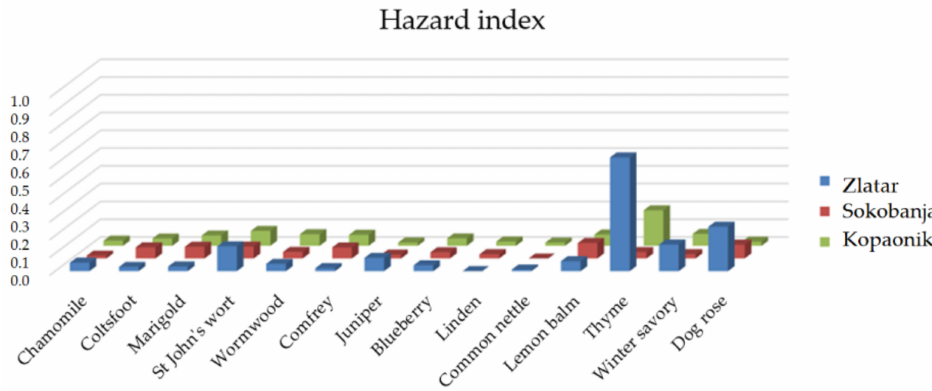
Figure 2. Hazard index of investigated medicinal